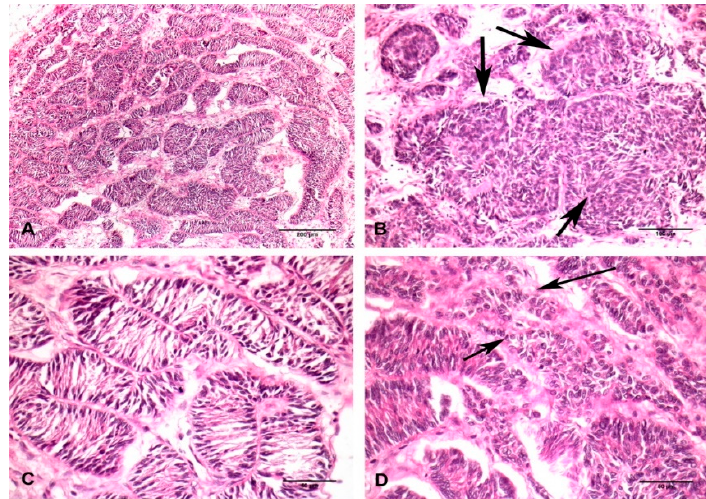
Figure 2. Histopathological picture of Sertoli cell tumor isolated from the testicle of a black bear. ( A ) General overview of Sertoli cells arranging in a tubular pattern with an occluded lumen. H&E staining. Bar = 200 μ m. ( B ) Several tubules containing Sertoli cells merged together forming multiple large round masses of varied sizes (indicated by arrow). H&E staining. Bar = 100 μ m. ( C ) Spindle-shaped Sertoli cells showing dark nuclei and small amounts of cytoplasm, these cells formed a bridge across the inner sides of tubules. H&E staining. Bar = 50 μ m. ( D ) Well-differentiated Sertoli cells showing round-to-oval nuclei forming irregular shaped tubules (indicated by arrow). H&E staining. Bar = 50 μ m.